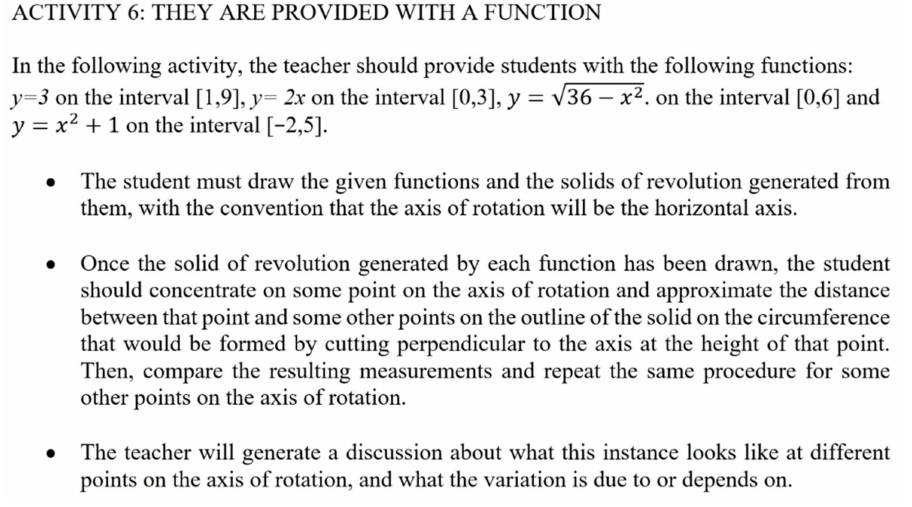
Figure 2. Graphing activity. Note: The activity was delivered to teachers in